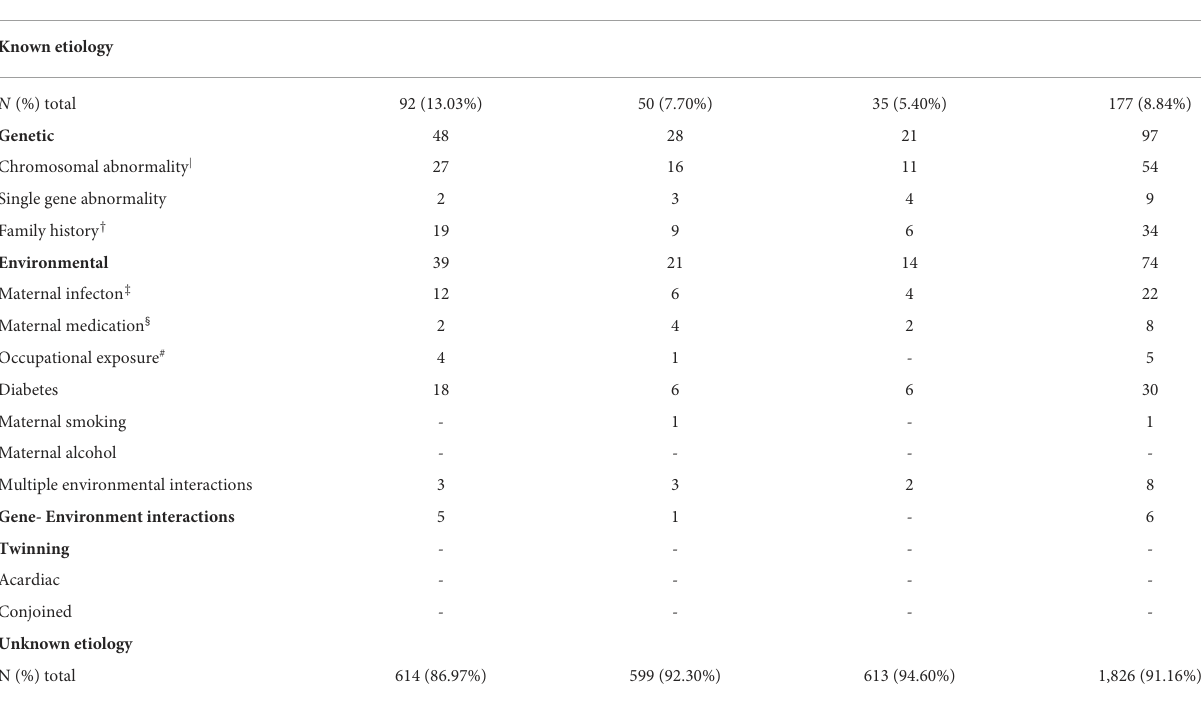
TABLE 3 Etiologic classification of birth defects in Guilin,